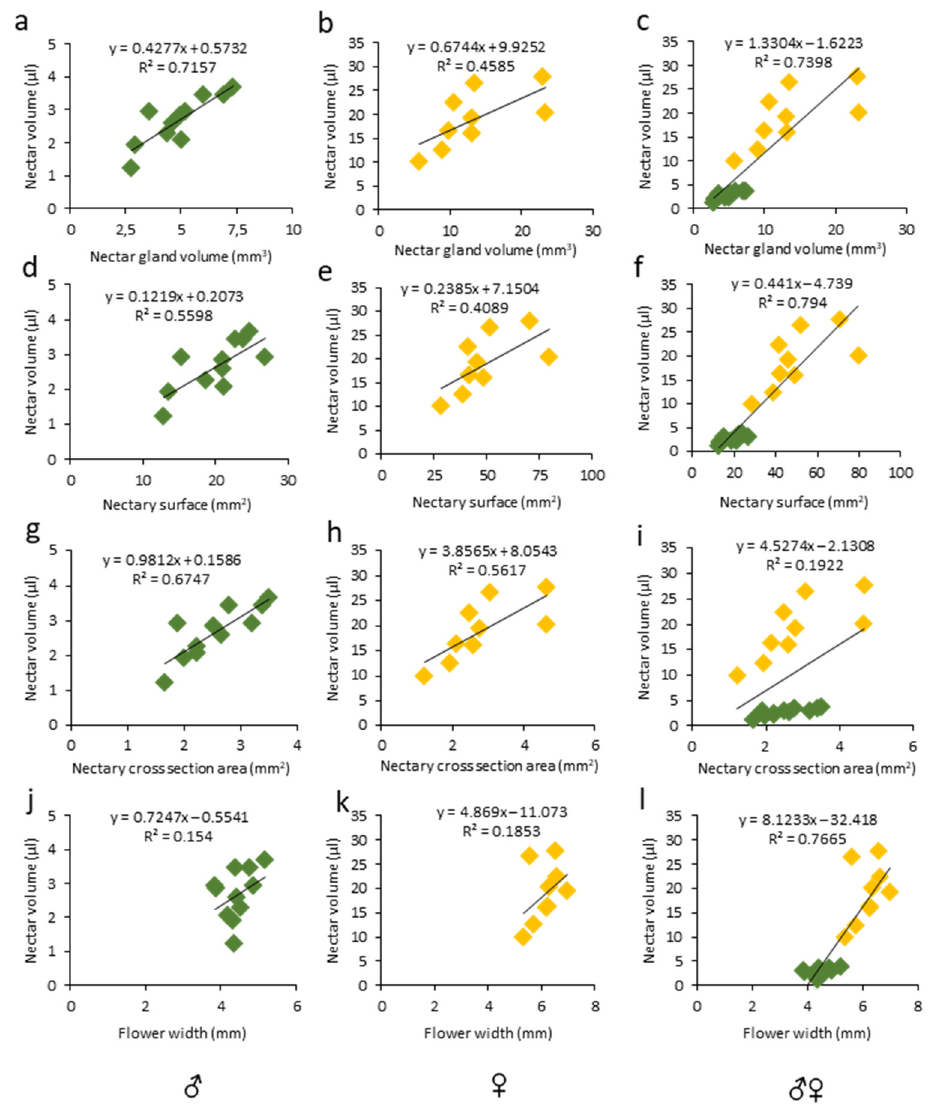
Figure 5. Linear regression and correlation analysis between nectar volume and ( a – c ) nectar gland volume, ( d – f ) 2D nectary surface, ( g – i ) nectary cross‑section area, and ( j – l ) flower width in the respective male, female, and pooled melon flowers. R 2 coefficients with equations are shown above each slope. Number of samples (n) was 11 and 9 for male (green) and female (yellow) flowers, respectively.